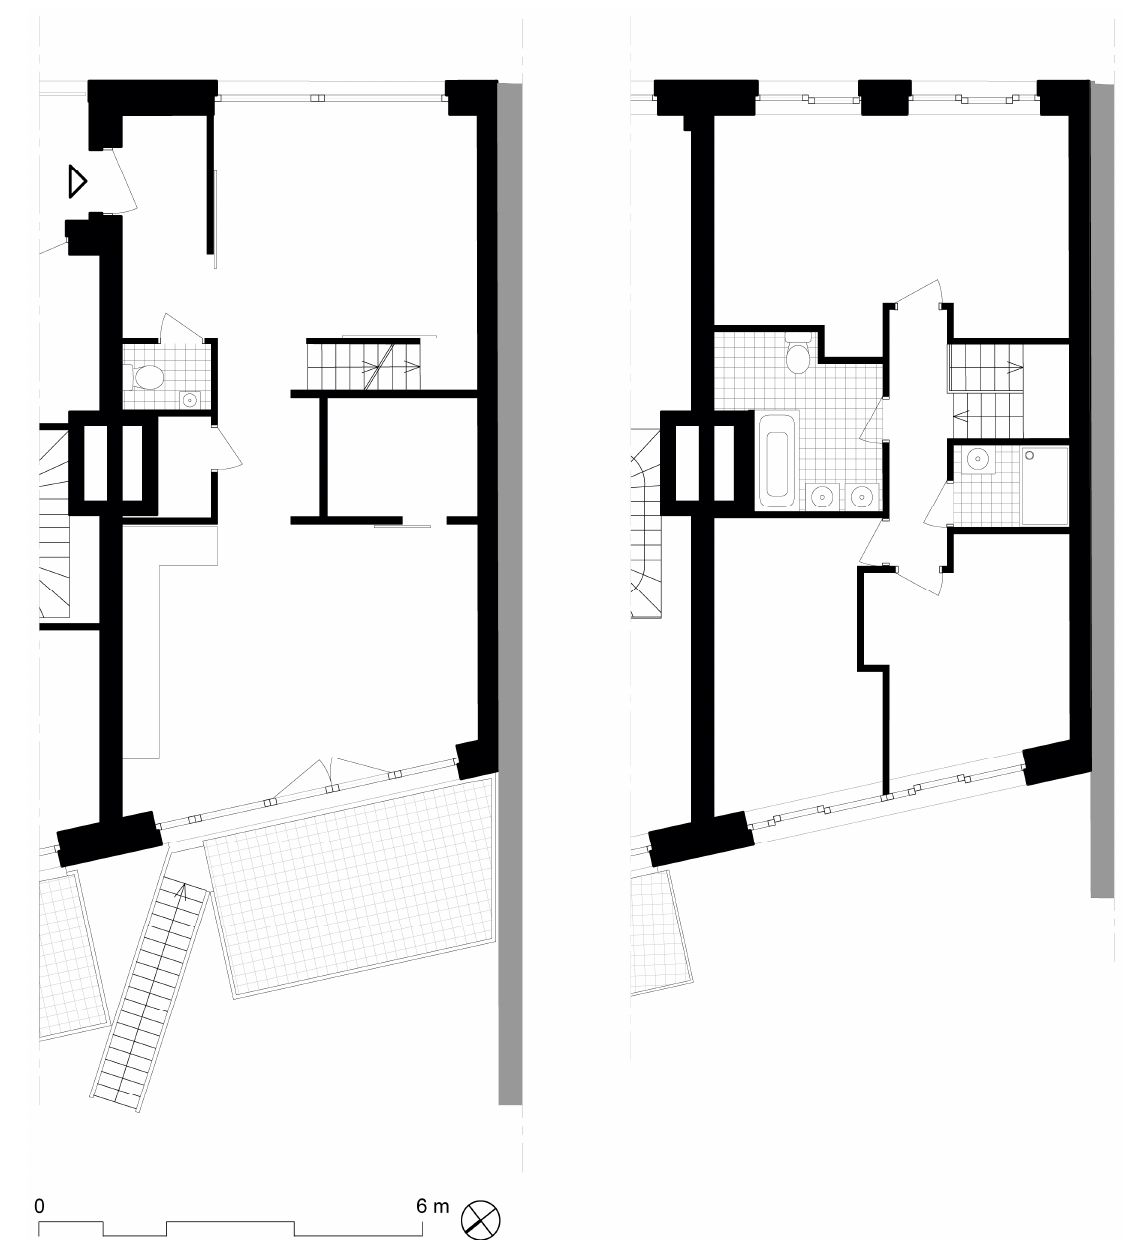
Figure 12. Dwelling plan of the project “Brutopia” by Stekke + Fraas architects (re-drawing by the authors).